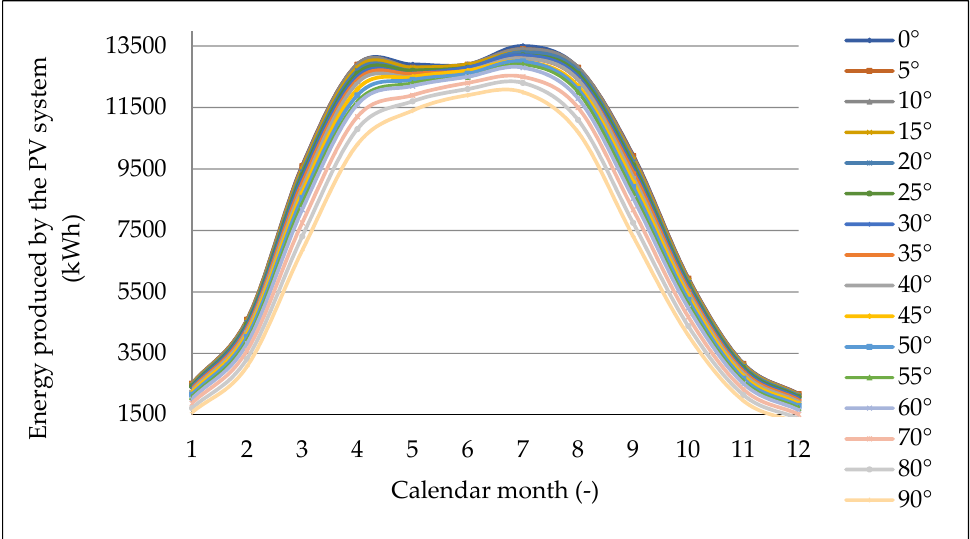
Figure 12. Dependencies of energy produced by the PV system for azimuth angle from 0° to 90° in different calendar months.